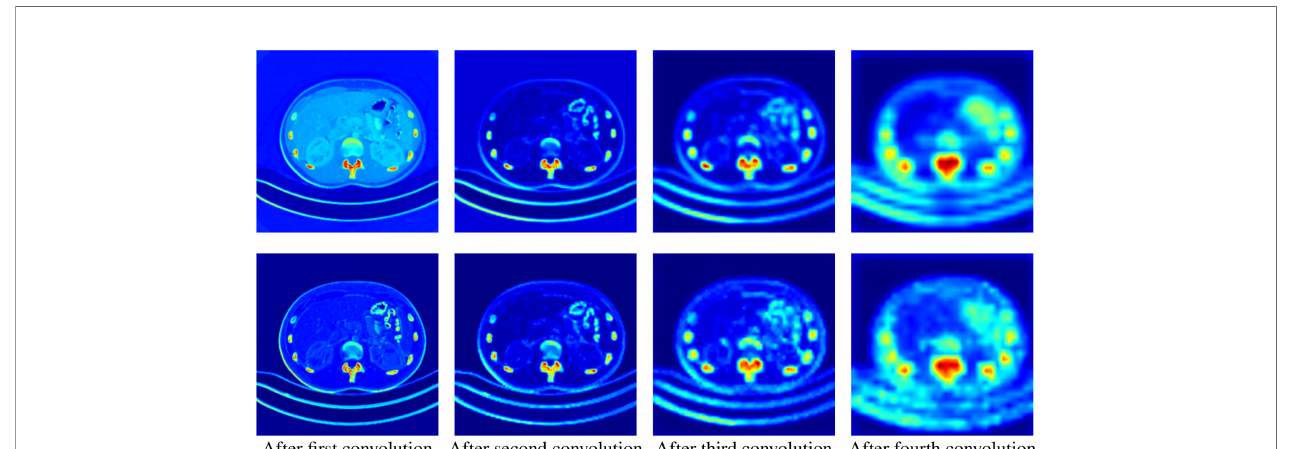
FIGURE 6 | Activation maps transformed from feature maps of different levels. The upper row is the average activation maps over channels, and the lower row is the max activated maps over channels. From left to right, the activation maps are from the output of the fi rst to the fourth downsampling block,